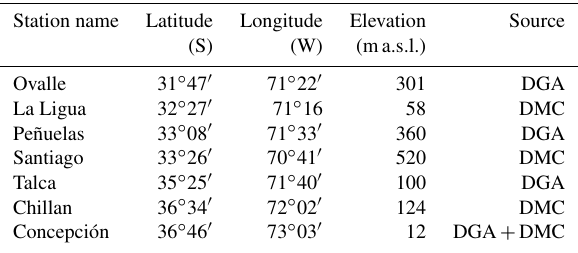
Table 1. Stations with annual mean rainfall from (at least) 1915 on- wards, used for the calculation of the regional precipitation index (RPI). Sources: DGA (National Water Directorate) and DMC (Na- tional Weather